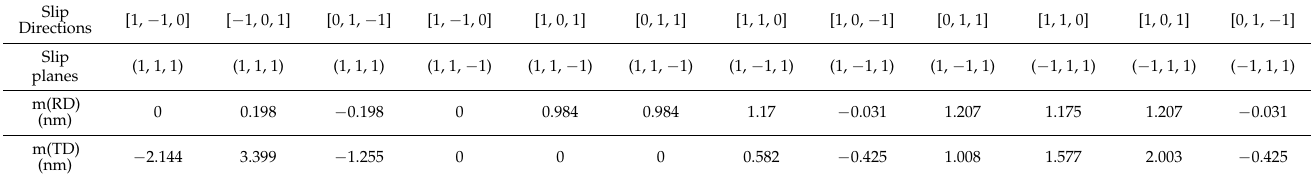
Table 3. Schmid factor to analyze the activated slip systems along the TD and RD for the Cu